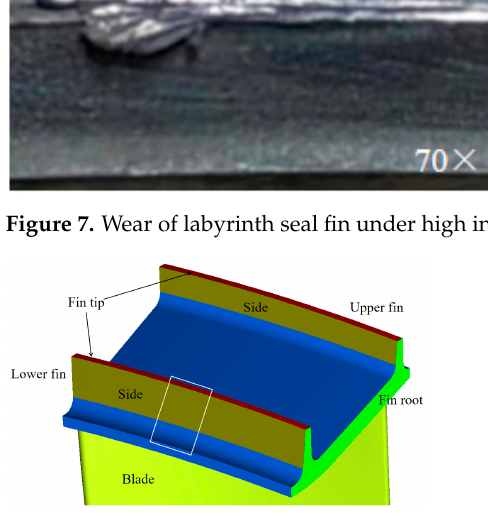
Figure 8. Definition of each face of the labyrinth seal fin.